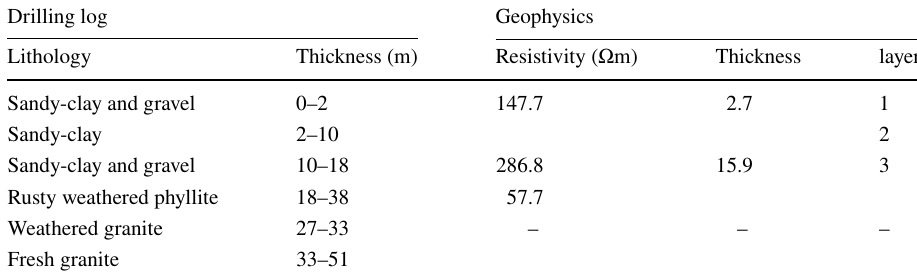
Table 1 Correlating lithology deduced from geophysics with the drilling results (Okrah et al. 2012)